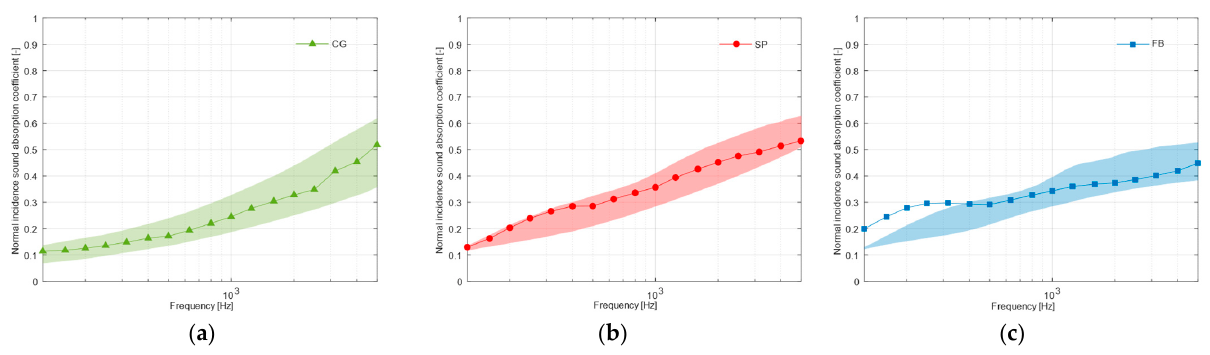
Figure 10. Measured average sound absorption curves for each mix and range (colored area) of the variation of the predicted normal sound absorption coe ffi cient: ( a ) CG mix, ( b ) SP mix, ( c ) FB mix.